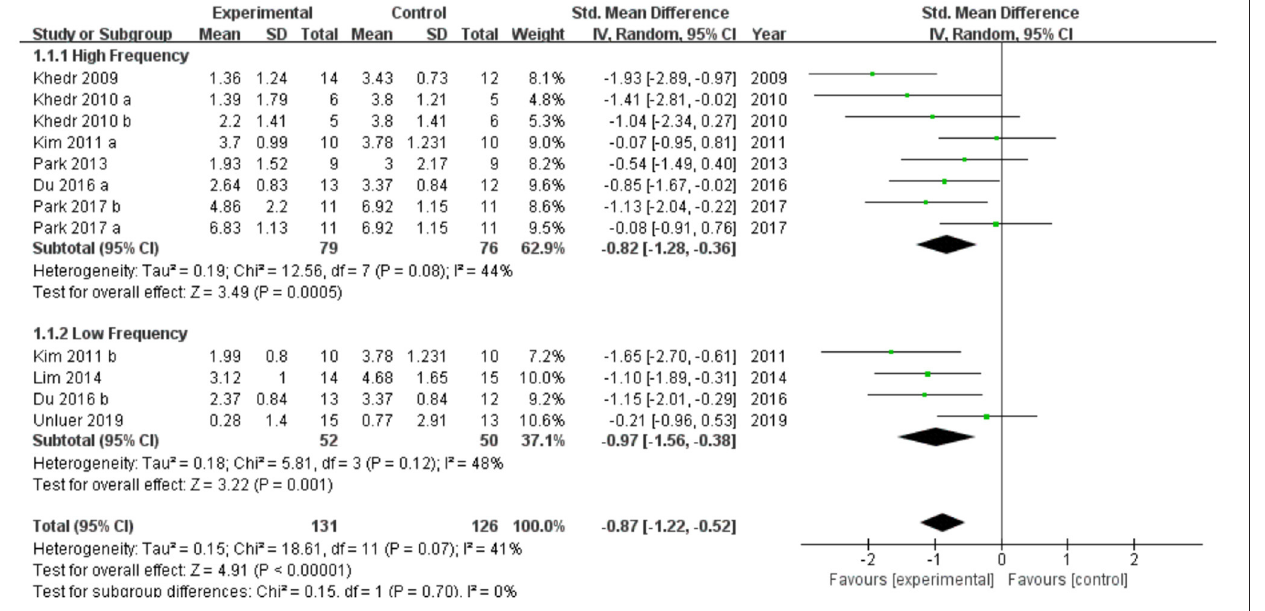
FIGURE 1 | Forest plot of changes from baseline to checkpoint for swallowing function. SMD, Standardized mean difference; CI, confidence interval; N, number of